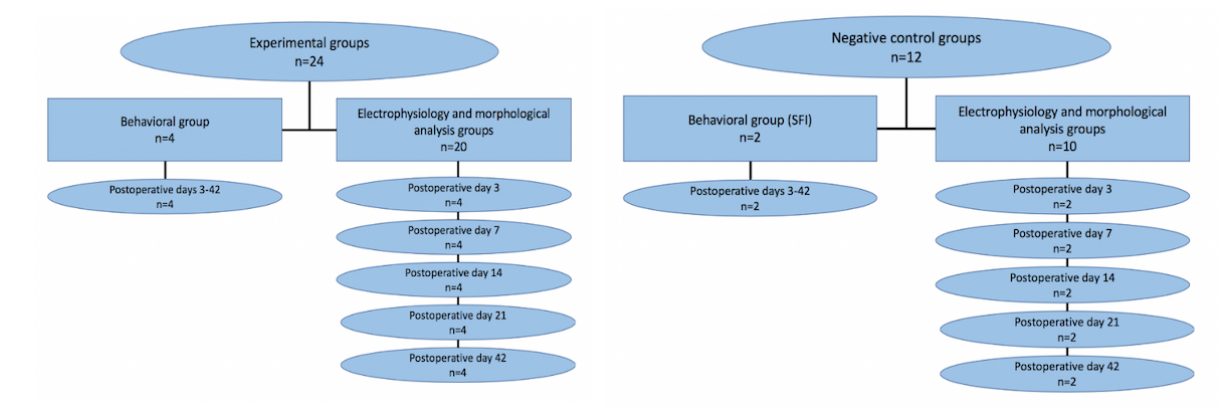
Figure 1. Experimental and negative control groups. The left flowchart represents the behavioral group breakdown and the right flowchart represents the negative control group breakdown. In both experimental and negative control groups, there will be behavioral and electrophysiological/morphological groups. In the electrophysiological/morphological groups, re-exploration and analysis will be performed on postoperative days 3, 7, 14, 21, and 42. SFI: sciatic functional